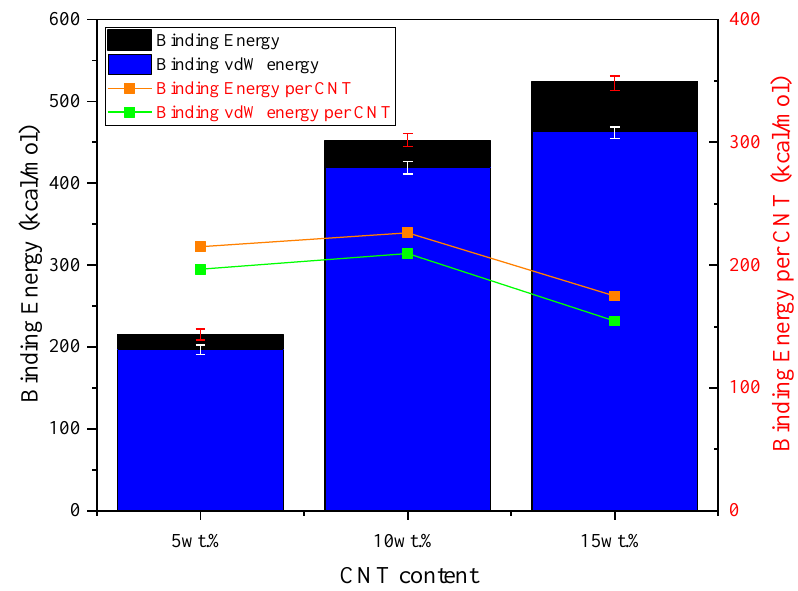
Figure 10. The binding energy of CNT/VNR composites with different CNT contents.